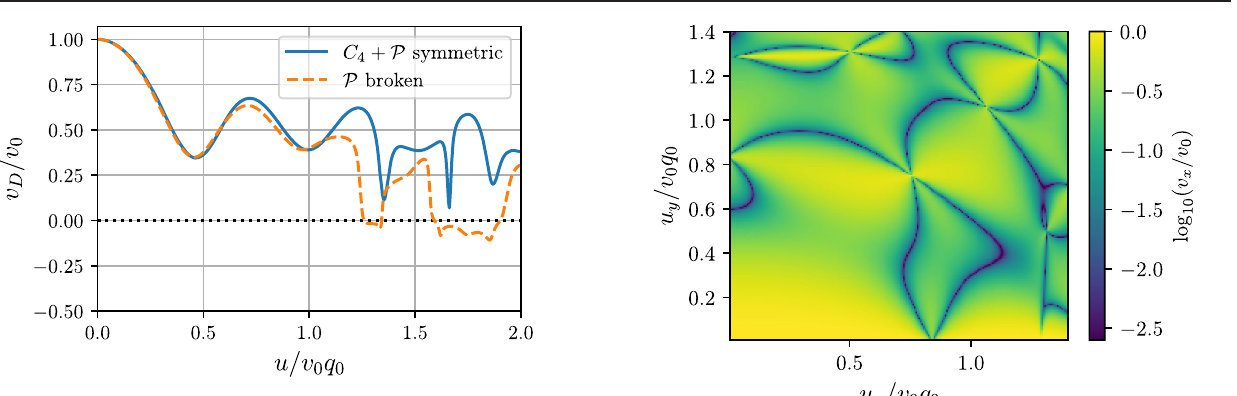
FIG. 3. The Dirac velocity of the Hamiltonian Eq. (13) with a C 4 -symmetric potential in the P -symmetric and P -broken case. The P -symmetric case is defined by the potential Eq. (16) with u ¼ u u , while the P -broken plot is given for the potential x ¼ y Eq. (17) with u 1 ¼ u; u 2 ¼ ð u= 4 Þ . In the latter case, the velocity is defined as the velocity of the Dirac cone connected adiabati- cally to the Dirac cone at zero energy as u is increased. One can see that v can reach 0 when the P antisymmetry is broken, but x not when it is present.